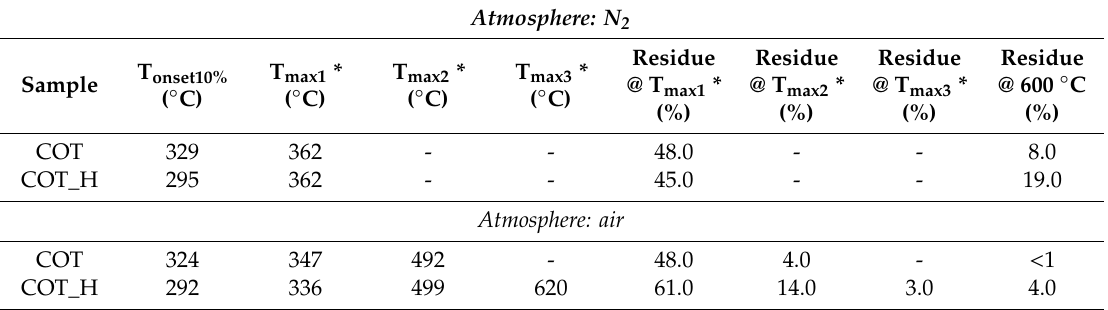
Table 6. Results from thermogravimetric analyses for untreated (COT) and hydrophobin-treated (COT-H) cotton